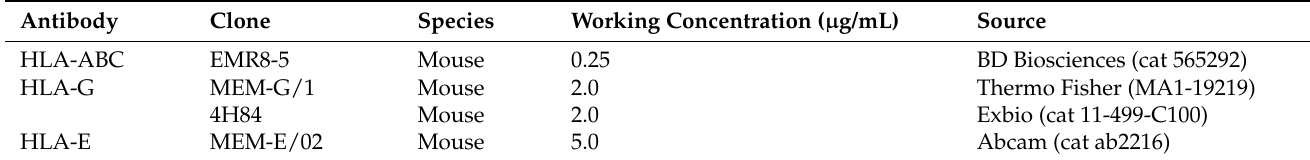
Table 2. Primary antibodies used in IHC